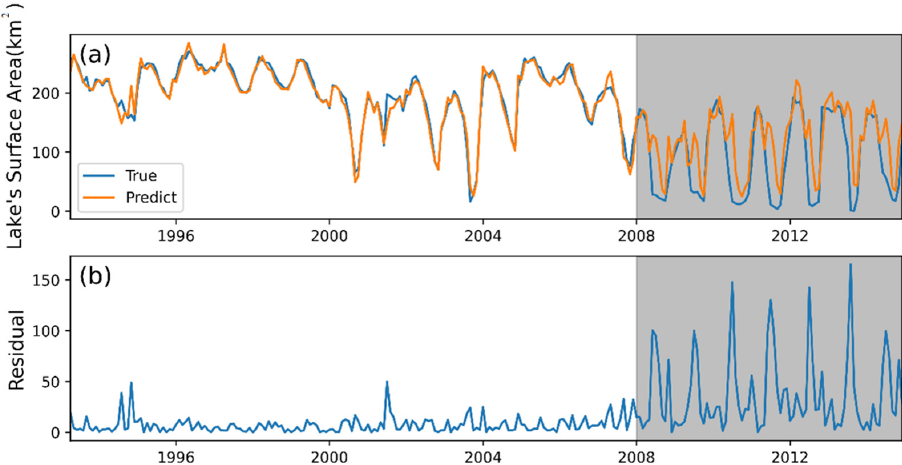
Figure 6. Prediction results of the lake’s surface area obtained from MLP model I. ( a ) Predictions for the lake’s surface area (km 2 ) and ( b ) Residual from the model.